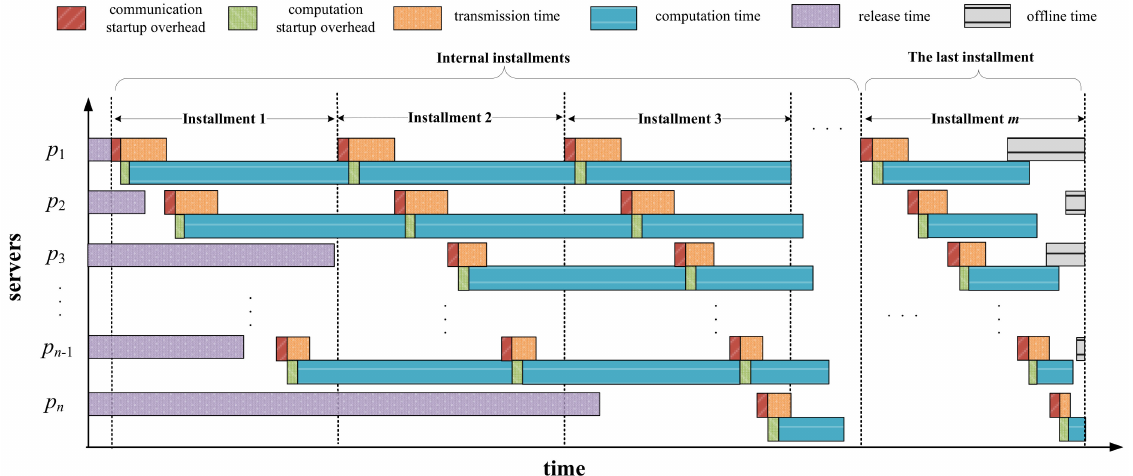
Figure 3. Multi-installment scheduling before applying repair strategy.